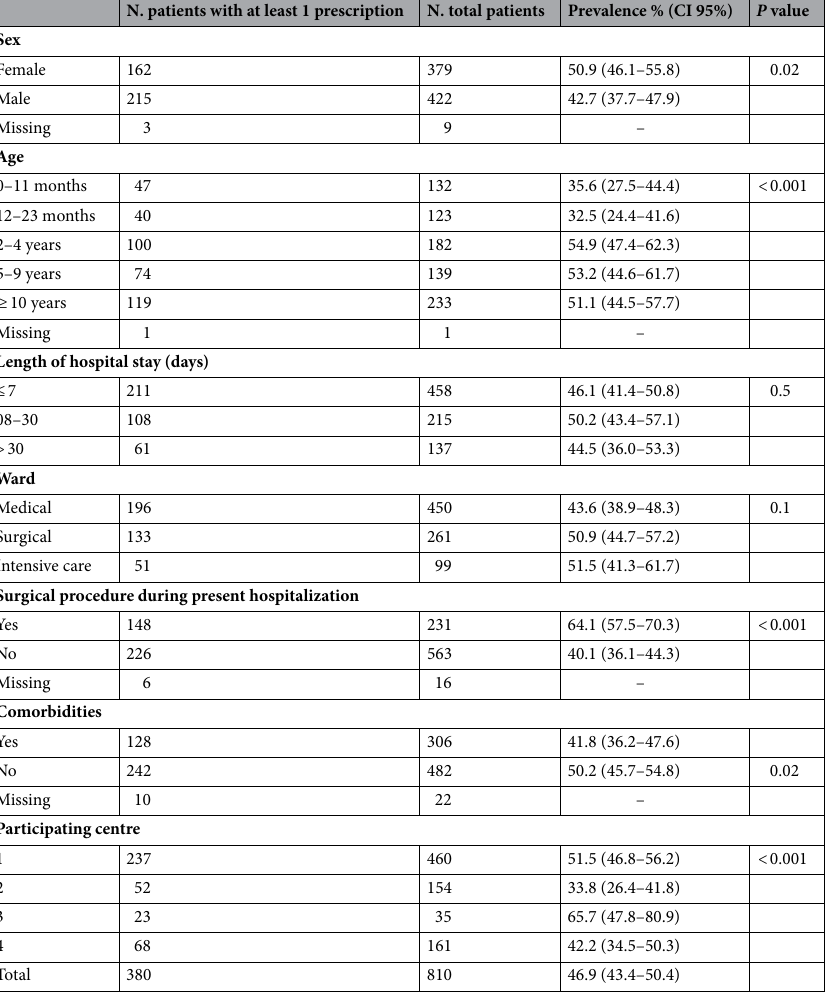
Table 1. Characteristics of patients receiving therapeutic and prophylactic antimicrobials in Italian Pediatric Hospitals,